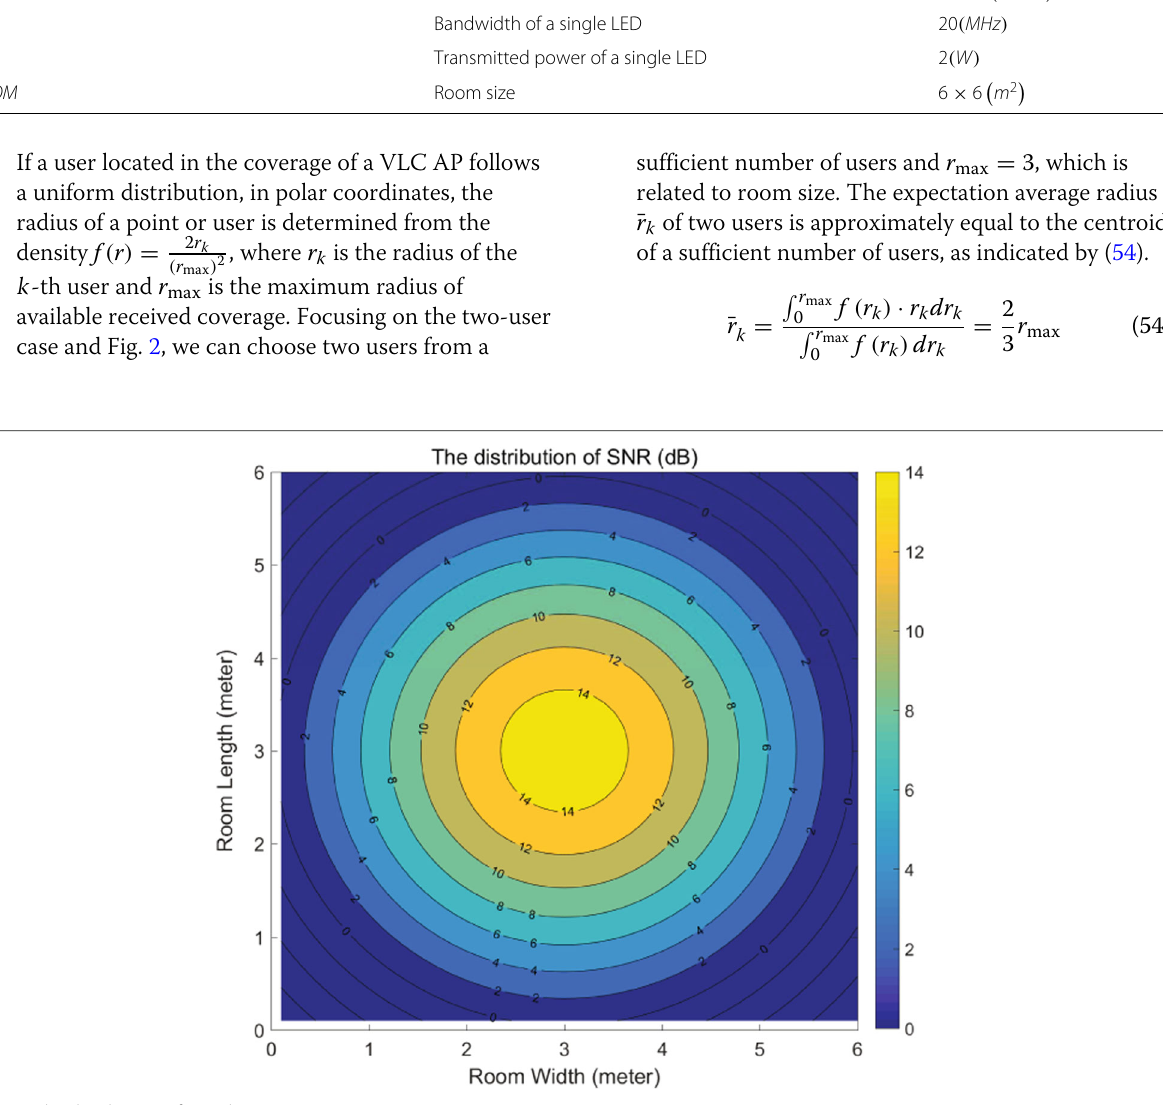
Fig. 2 The distribution of signal-to-noise ratio